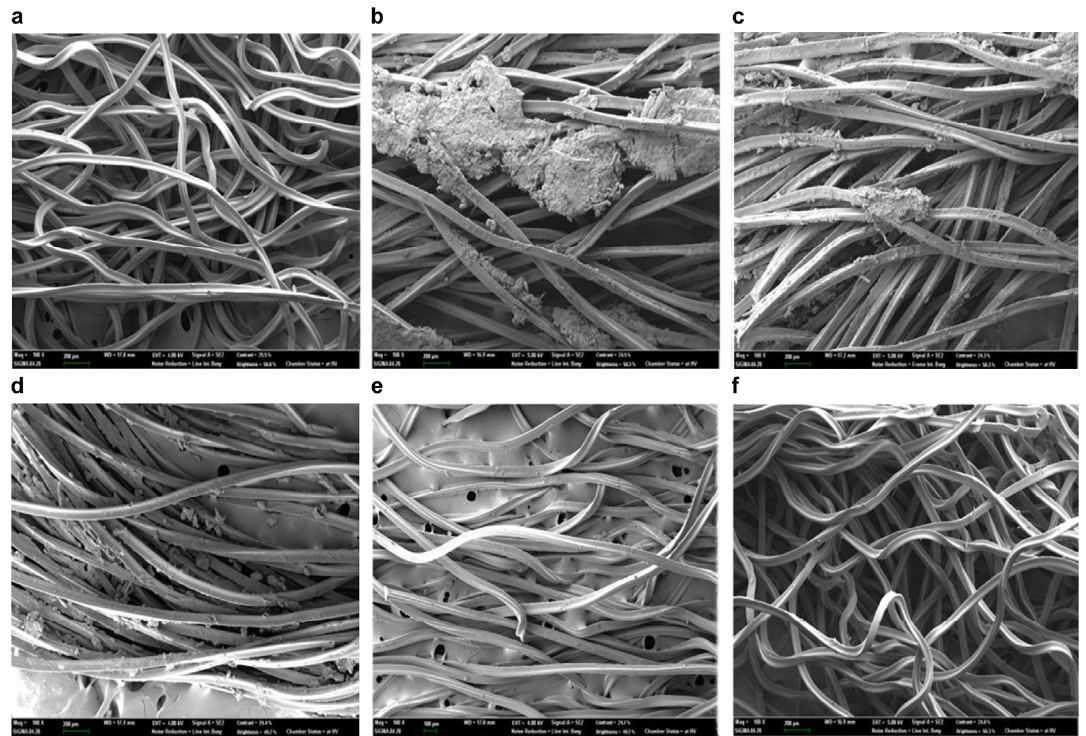
Figure 7. Scanning electron microscopy (SEM) images of the ( a ) virgin fiber media filter and fiber media filter after ( b ) 20 h of operation, ( c ) physical backwashing, ( d ) chemical soaking with 500 mg/L of NaClO, ( e ) chemical soaking with 1000 mg/L of NaClO, and ( f ) chemical soaking with 2000 mg/L of NaClO.